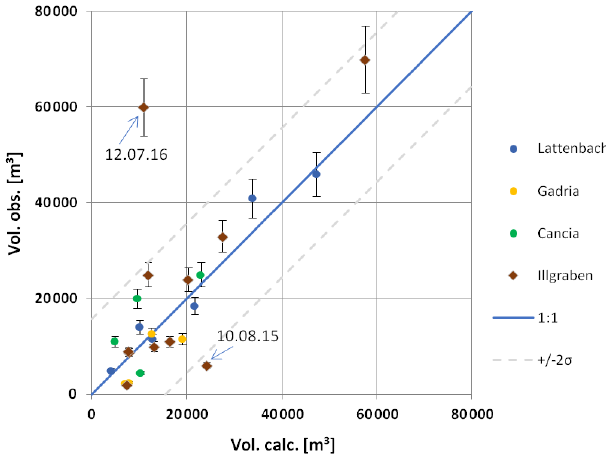
Figure 7. Comparison of the predicted volume vs. observed vol- ume. The dark blue line represents the one-to-one relationship, and the dashed lines represent the confidence interval of the